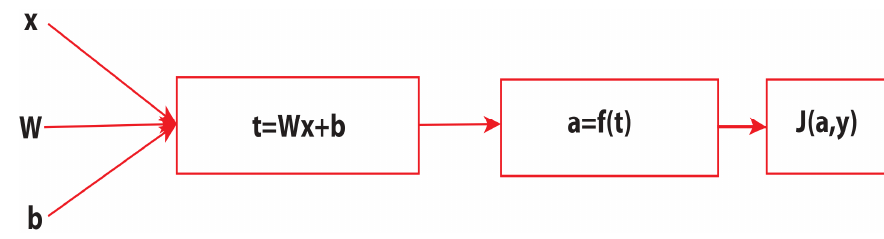
Figure 5. Flow chart for the linear transformation.